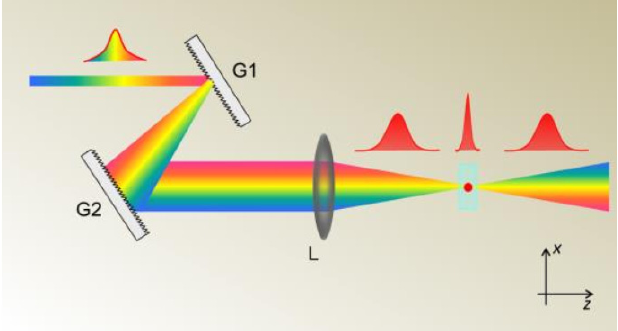
Figure 1. Schematic illustration of the typical SSTF (simultaneous spatial and temporal focusing) system. G1, G2: grating pair; L: lens. Reproduced with permission from [27], Copyright The Optical Society, 2015.